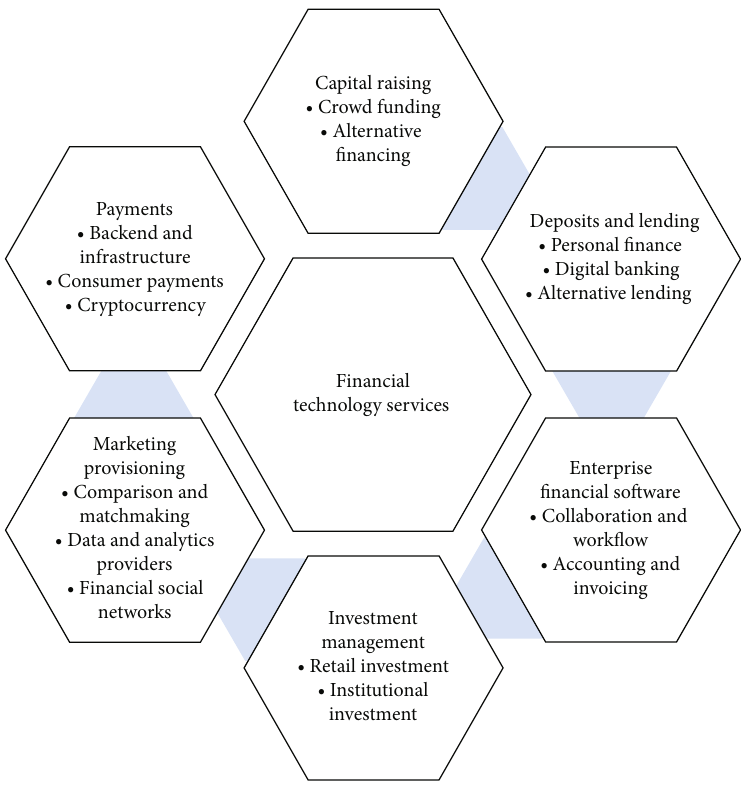
Figure 1: Financial technology